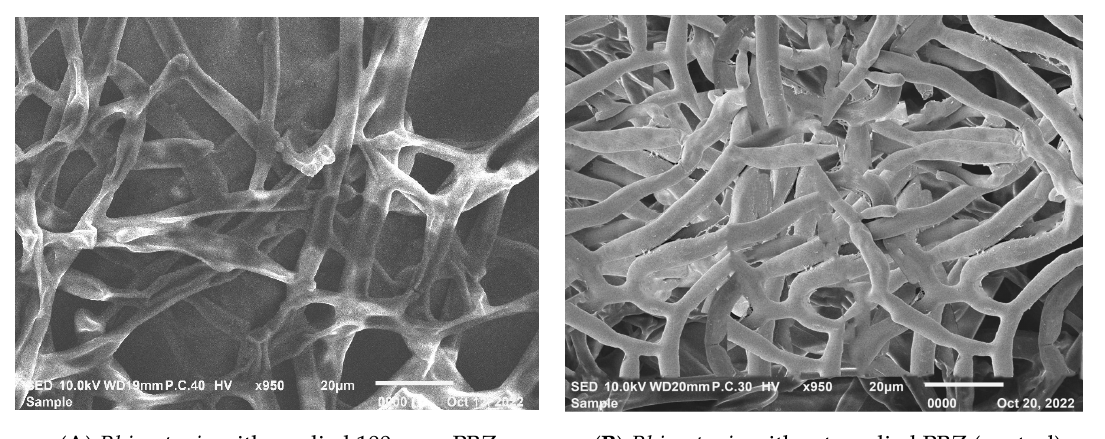
Figure 1. In vitro antifungal activity of paclobutrazol (PBZ) under different applied doses against Rhizoctonia solani , where there is no significance among the applied doses on growth of mycelium compared with recommended fungicide (Rizolex 50% WP) .